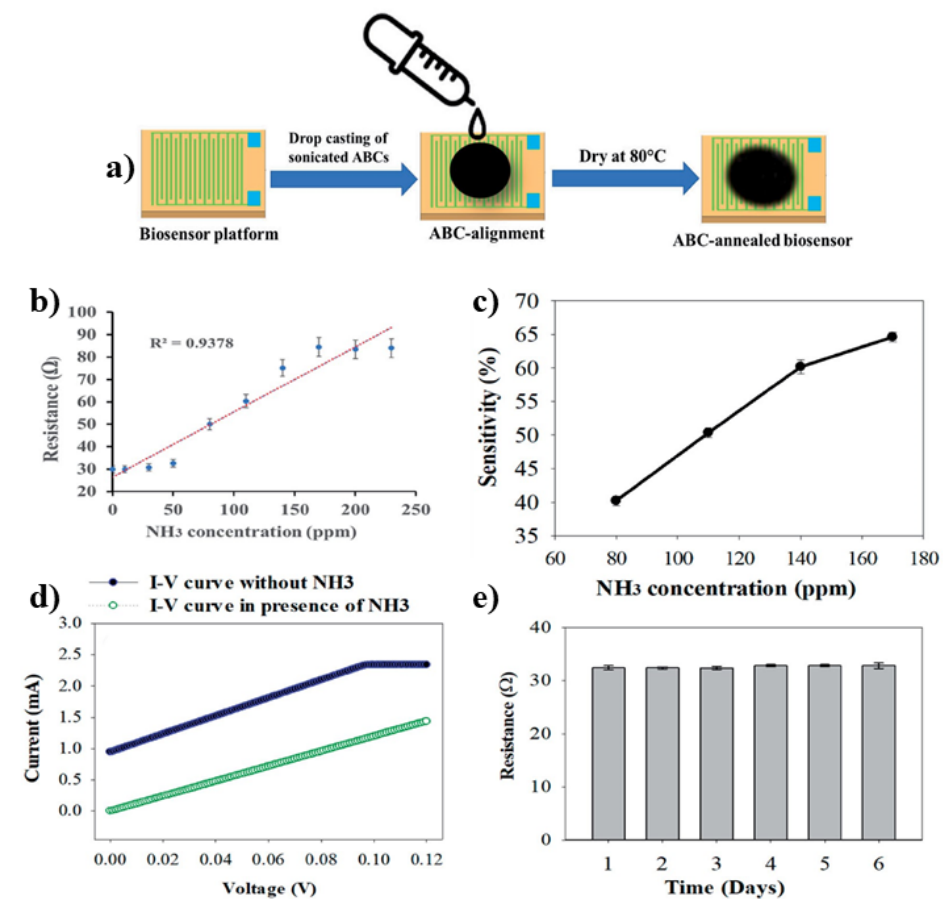
Figure 5. Schematic representation of ABC/PLA ‐ based biosensor fabrication ( a ) and its analytical performances (from ( b – e )). In particular, in ( b ) the resistance response to NH 3 concentrations, in ( c ) the sensitivity, in ( d ) the comparison of I ‐ V data of 85% ABC/PLA ‐ based biosensor in the presence/absence of NH 3 and ( d ) the stability of the biosensor using a fixed concentration of NH 3 (50 ppm) was reported.